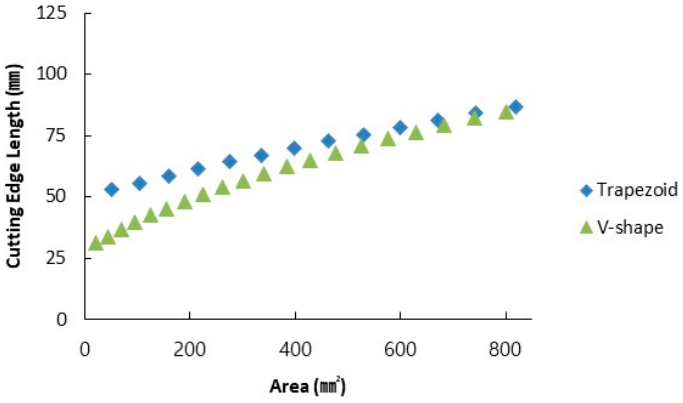
Figure 10. Cutting edge length.